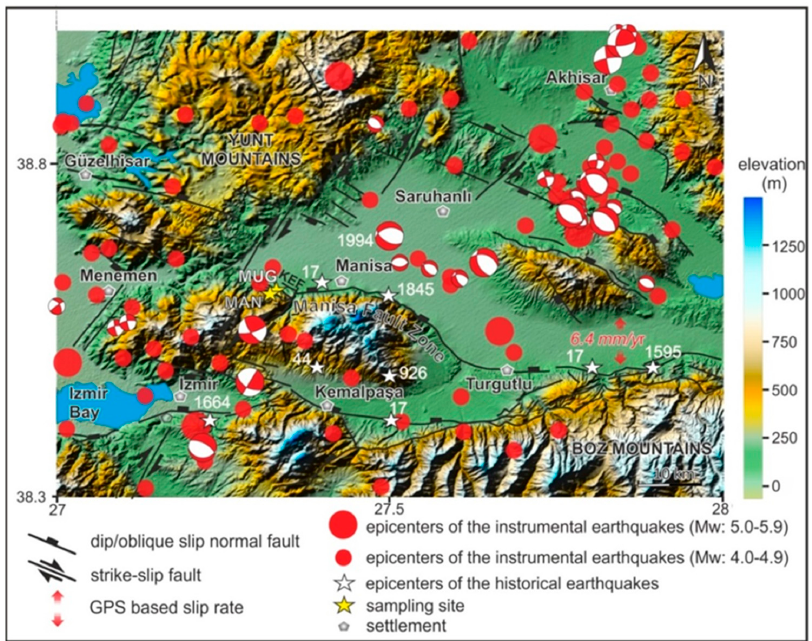
Figure 2. Seismotectonic map of the Izmir-Manisa region showing the epicenters of instrumental and historical earthquakes (modified from [59]). MAN: Manastır fault, MUG: Mugırtepe fault, KEF: Keçiliköy fault; GPS based slip rate is from [47].